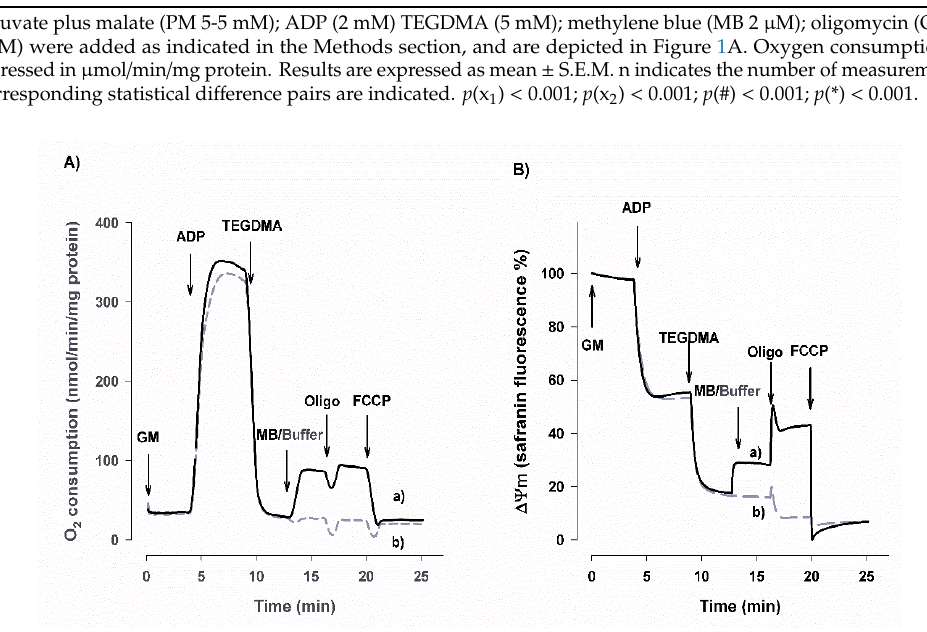
Figure 1. E ff ects of TEGDMA on the oxygen consumption ( A ) and membrane potential ( ∆ ψ m ; B ) of isolated brain mitochondria in the presence or absence of methylene blue (MB; 2 µ M), respiring on glutamate plus malate (GM). Mitochondria were incubated in the ’respiratory medium’ described under Materials and methods. ADP, TEGDMA and MB (black curve), TEGDMA and Buffer (dashed gray curve), oligomycin (Oligo), and uncoupler (FCCP) were given as indicated on the original representative traces. Semiquantitative estimation of ∆ ψ m . On the basis of safranin, fluorescence was calculated as detailed in Methods, according to the following equation: ∆ ψ m (%) = 100 × (1 − (F(saf) − Fmin) / (Fmax −